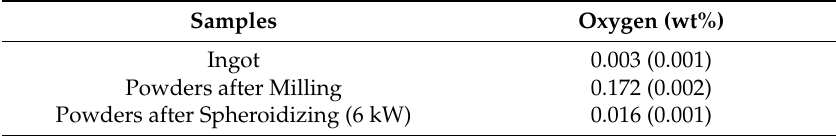
Table 2. Oxygen concentrations (in wt%) of the ingot, powders after milling, and powders after spheroidizing at a plasma power of 6 kW. The values given in parenthesis refer to standard